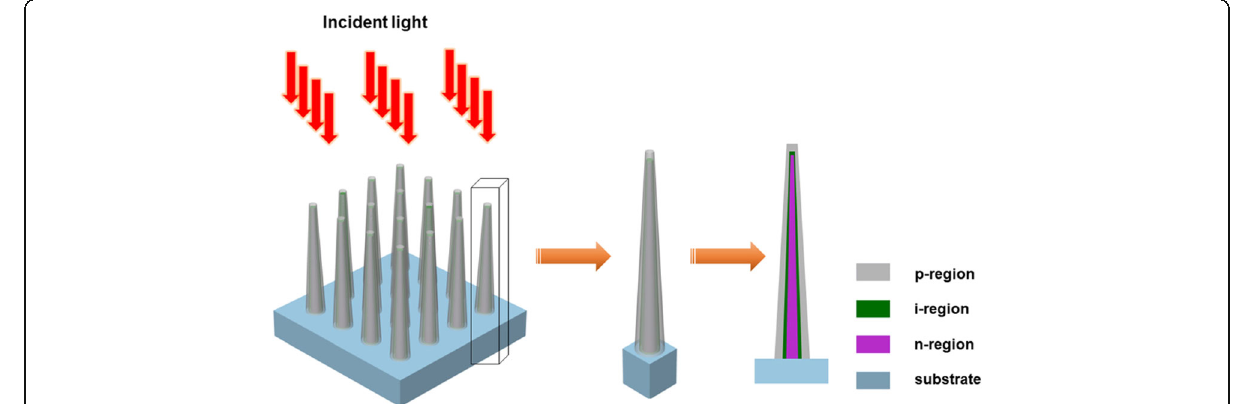
Fig. 6 The schematic diagram of the radial pin junction GaAs nanocone